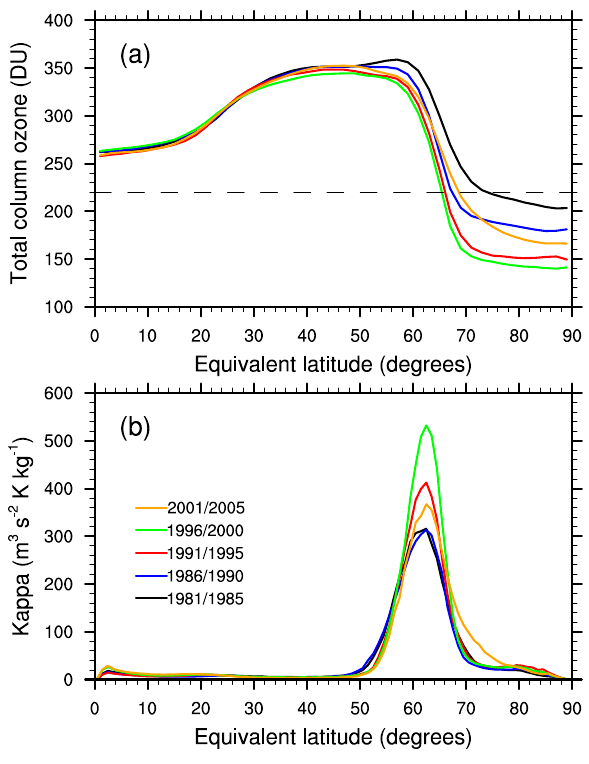
Fig. 1. Five year October averages (black: 1981-1985, blue: 1986-1990, red: 1991-1995, green: 1996-2000, orange: 2001-2005) of daily (a) total column ozone (DU) from NIWA total column ozone data-base and (b) 550K κ (m 3 s − 2 Kkg − 1 ) from NCEP/NCAR re-